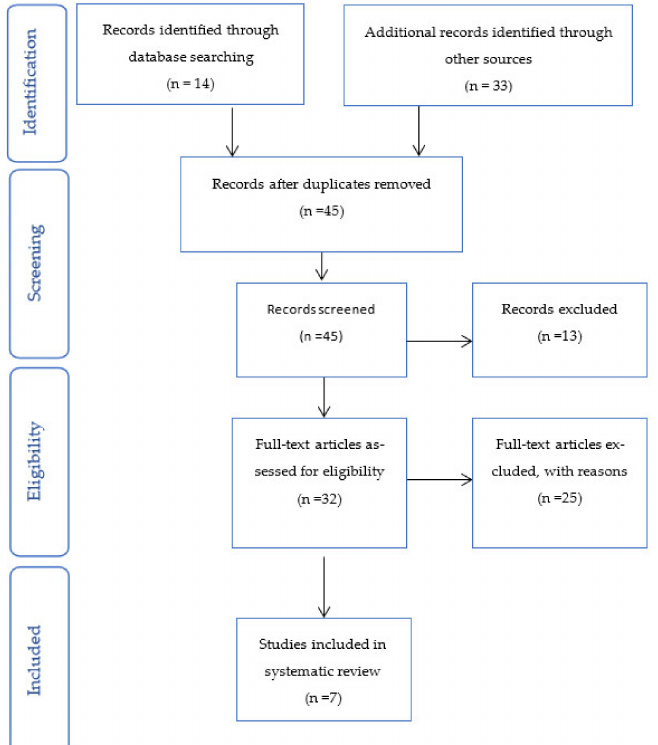
Figure 6. A PRISMA diagram summarising the literature search and selection process for study question 3—Does sperm selection by HAB improve clinical outcomes for all infertility